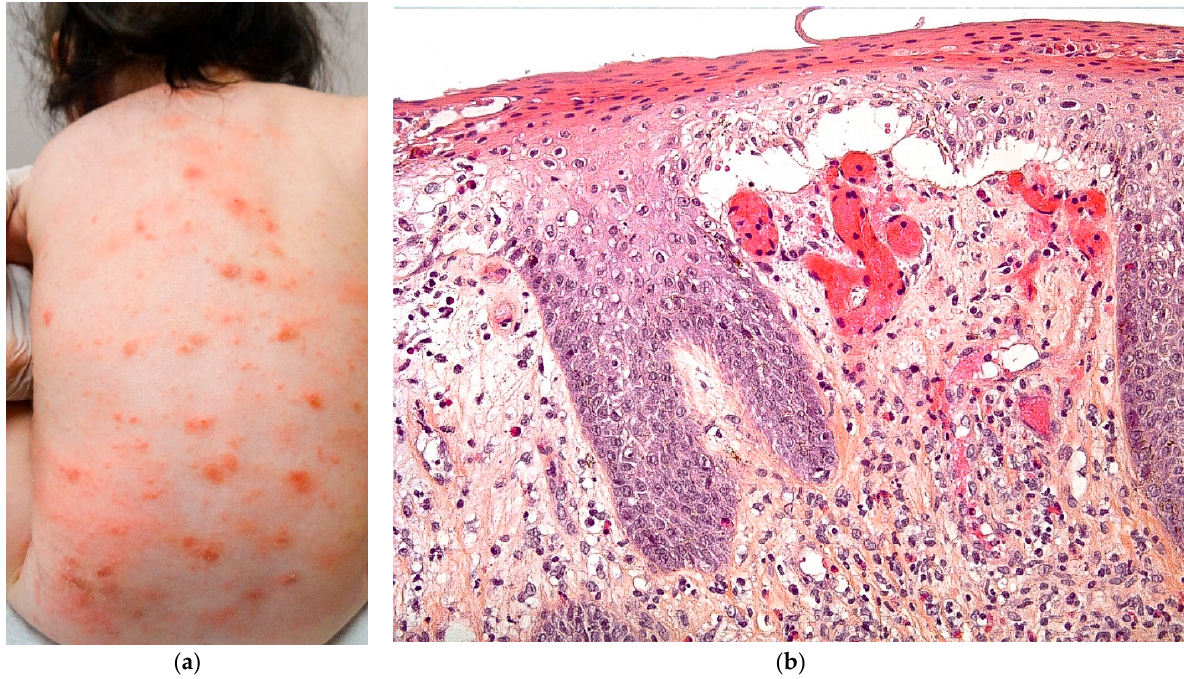
Figure 4. Scabies. ( a ) Blistering scabies. ( b ) Hematein eosin ×20: dermo ‐ epidermal blister and inflammatory infiltrate with eosinophils in the dermis.